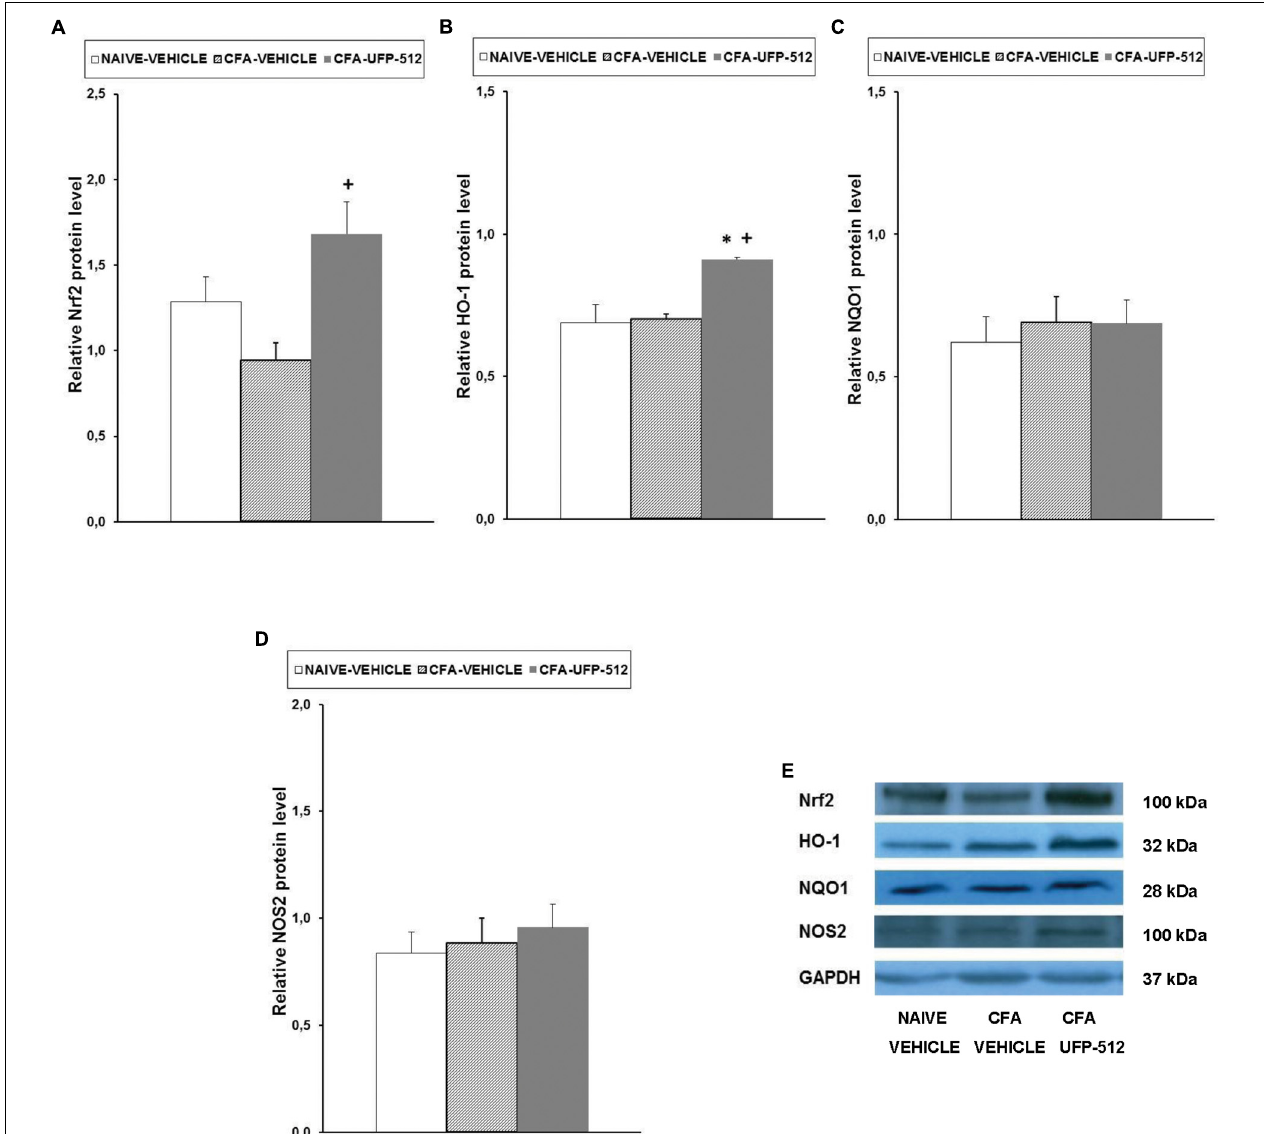
FIGURE 4 | Effects of UFP-512 on the expression of Nrf2, HO-1, NQO1, and NOS2 in the spinal cords of animals with peripheral inflammation. Protein levels of Nrf2 (A) , HO-1 (B) , NQO1 (C) , and NOS2 (D) in the ipsilateral site of the spinal cords of CFA-injected mice treated with UFP-512 (CFA-UFP-512) or vehicle (CFA-vehicle) are represented. Controls corresponding to naive mice treated with vehicle (naive-vehicle) are also shown. For each protein, ∗ indicates significant differences vs. naïve mice treated with vehicle and + indicates significant differences vs. CFA-injected mice treated with vehicle ( P < 0.05, one-way ANOVA, followed by the Student–Newman–Keuls test). Representative examples of western blots for Nrf2 (100 kDa), HO-1 (32 kDa), NQO1 (28 kDa), and NOS2 (100 kDa) proteins in which GAPDH (37 kDa) was used as a loading control are also shown (E) . Results are expressed as mean ± SEM; n = 4 samples per